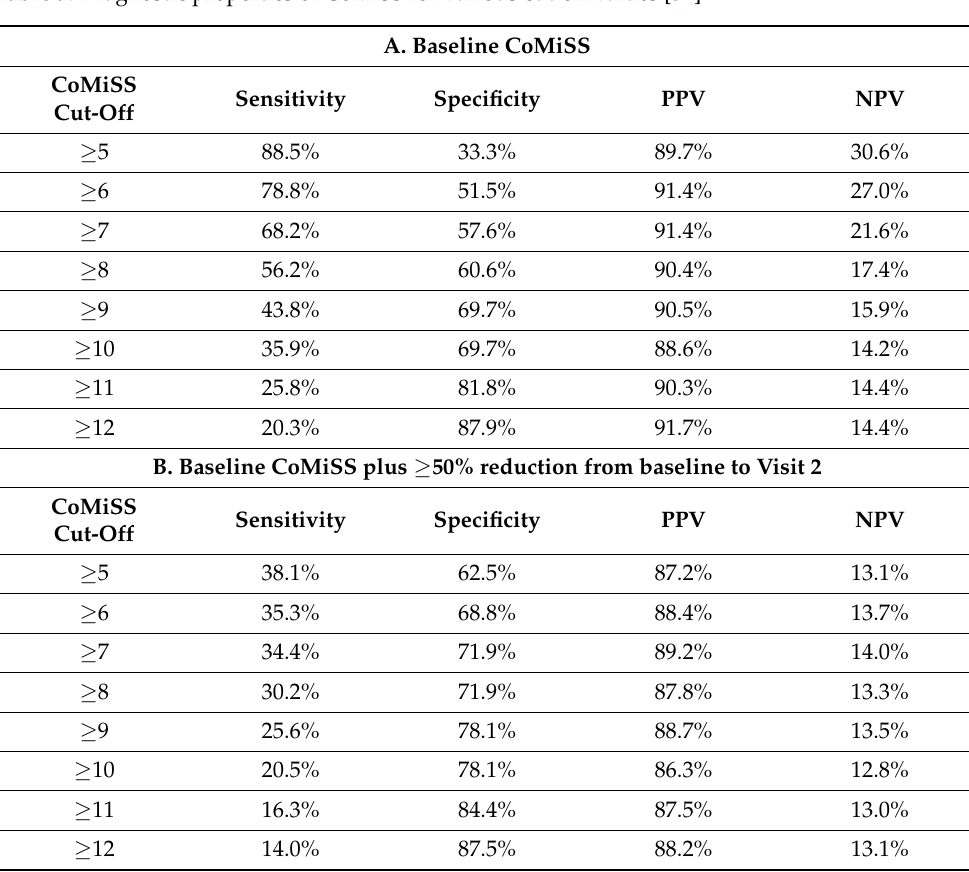
Table 9. Diagnostic properties of CoMiSS for various cut-off values